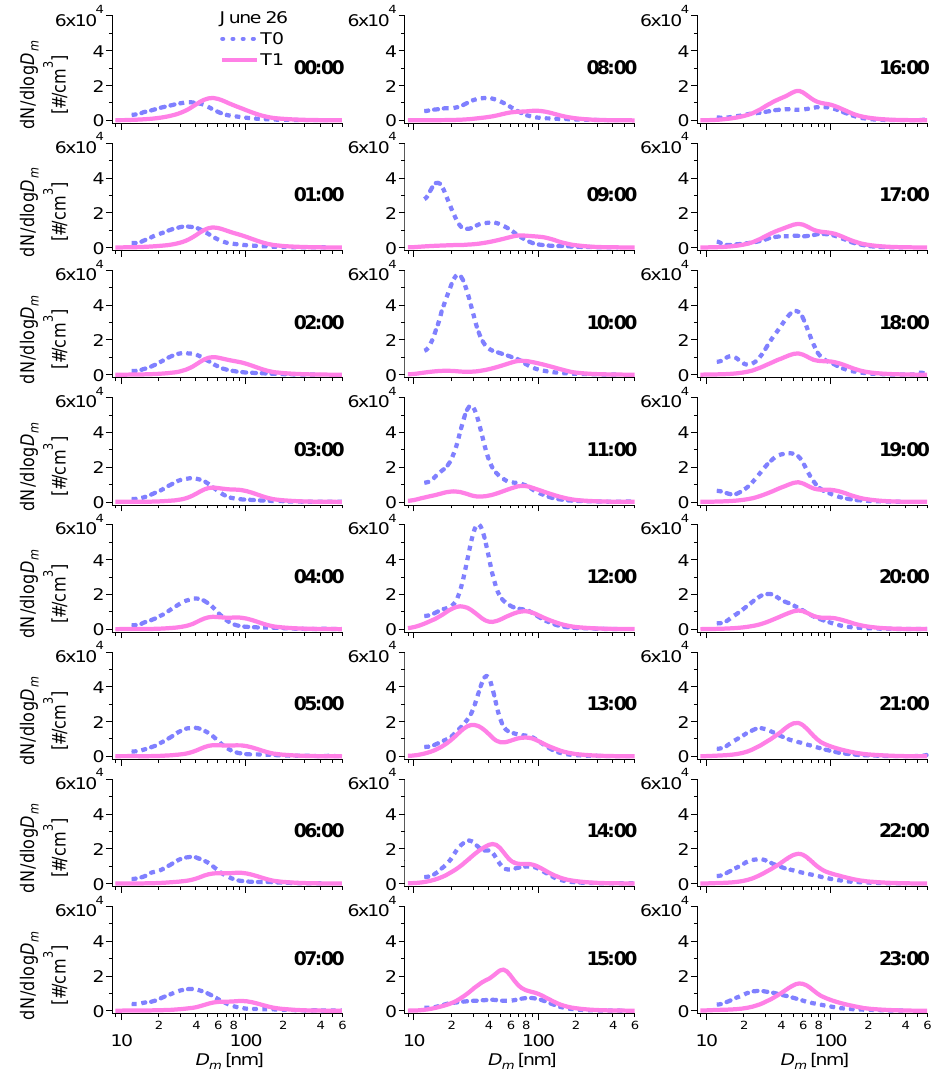
Figure 4. Comparisons of the average particle number size distributions for each hour at T0 and T1 during June 26.